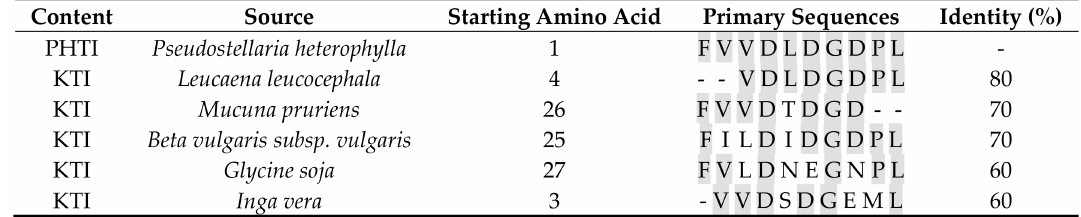
The N-terminal sequences listed in Table 2 are from the NCBI database (https://www.ncbi.nlm.nih.gov). The amino acids with background color mean that they are the same to the sequence of